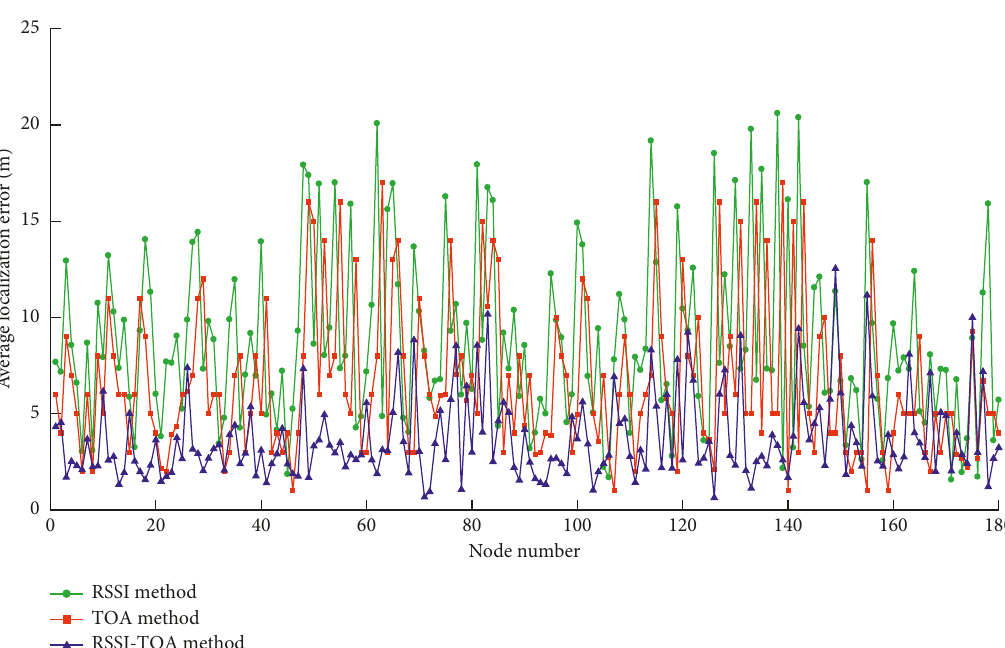
Figure 9: Localization error of each node in three localization